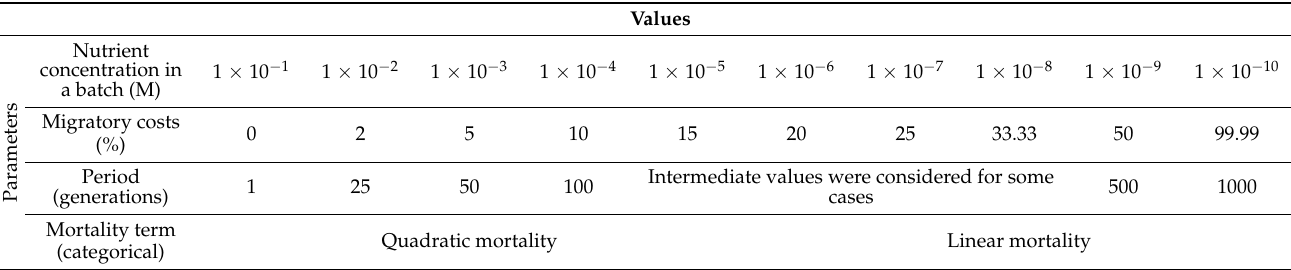
Table 1. Settler–Nomad model parameter values for the simulation scenarios considered in the study. For the full set of tested combinations of parameters see the Supplementary